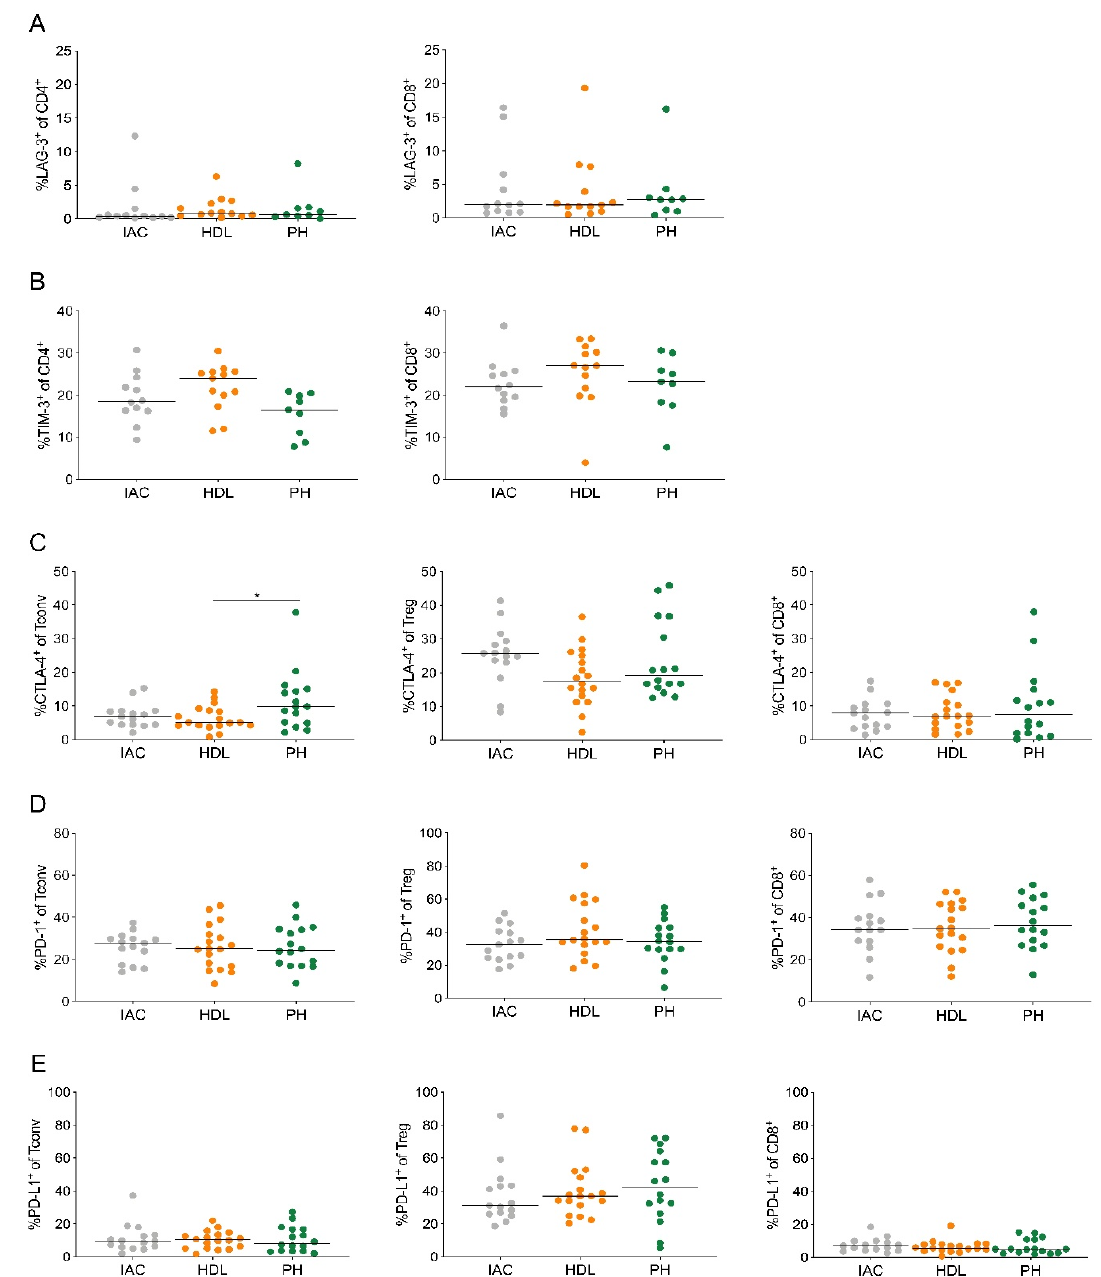
Figure 4. Treg cells in PDAC-draining lymph nodes express PD-1 and PD-L1. ( A ) Quantification of the expression of LAG-3 and ( B ) TIM-3 on CD4 + (left) and CD8 + T cells (right). ( C ) Quantification of the expression of CTLA-4, ( D ) PD-1 and ( E ) PD-L1 on CD4 + Tconv cells (Tconv; left), regulatory T cells (Treg; middle) and CD8 + T cells (CD8 + ; right). IAC, interaortocaval; HDL, hepatoduodenal ligament; PH, pancreatic head. Each point represents data from one patient. Data, median. One-way ANOVA. * p <